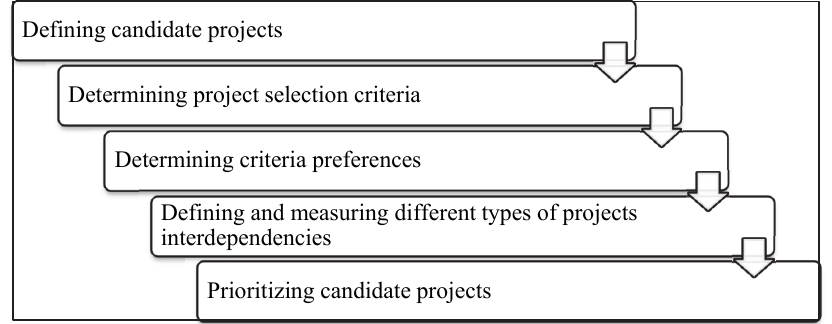
Fig. 5. The proposed framework for project portfolio